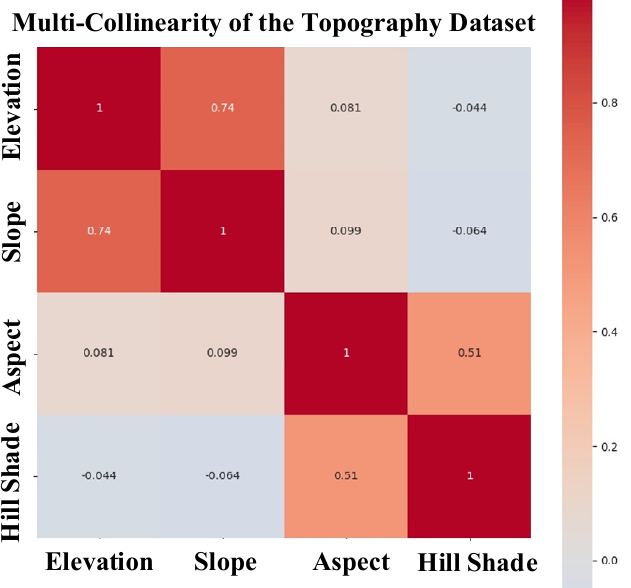
Figure 11. The correlation matrix of fuel factors as a heatmap.